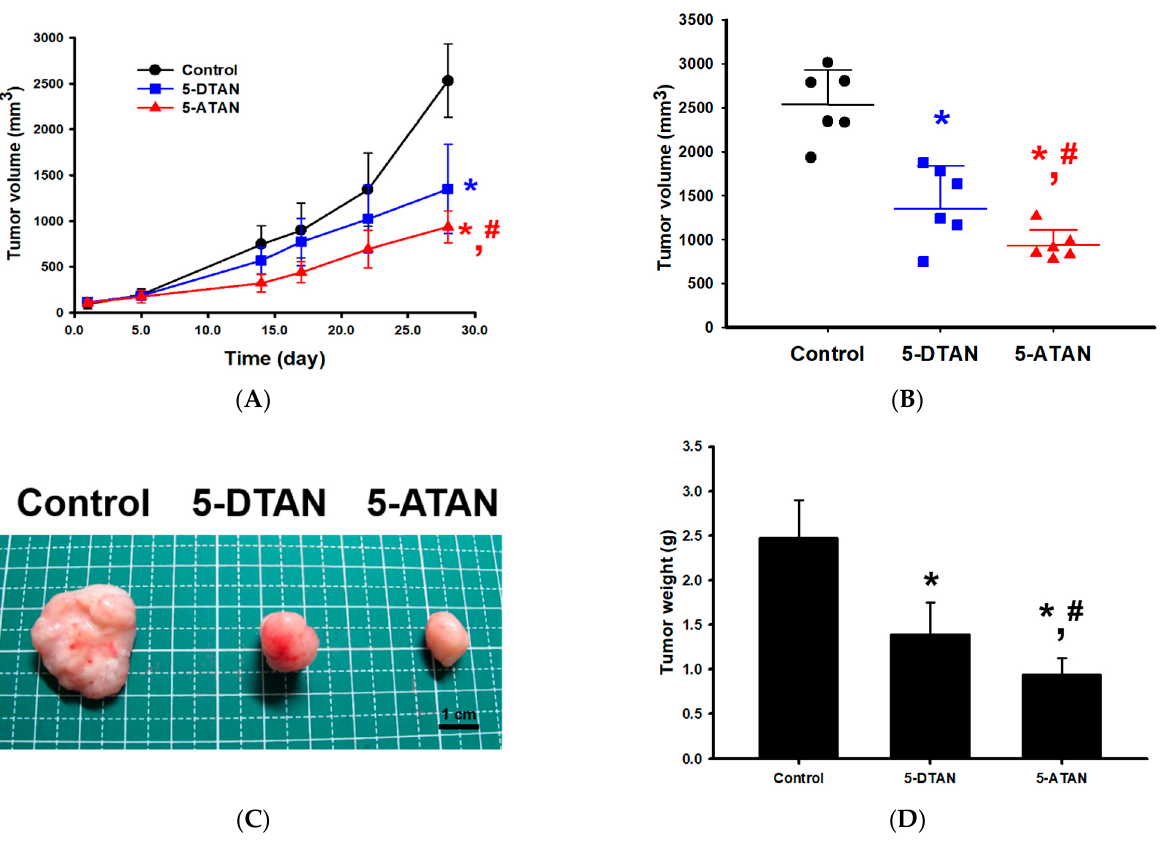
Figure 5. Effects of oral administration of 10 mg/kg 5-DTAN and 5-ATAN on the tumor growth of PC-3 cell xenografts. ( A ) The changes in tumor volume on the right flank side of nude mice as a function of time. ( B ) Tumor size at the end of the experiment. ( C ) The appearance of representative tumors harvested at the end of the experiment. ( D ) Mean tumor weight in nude mice. Data are expressed as means ± SD ( n = 6). * p < 0.05 compared with control group. # p < 0.05 compared with 5-DTAN group.